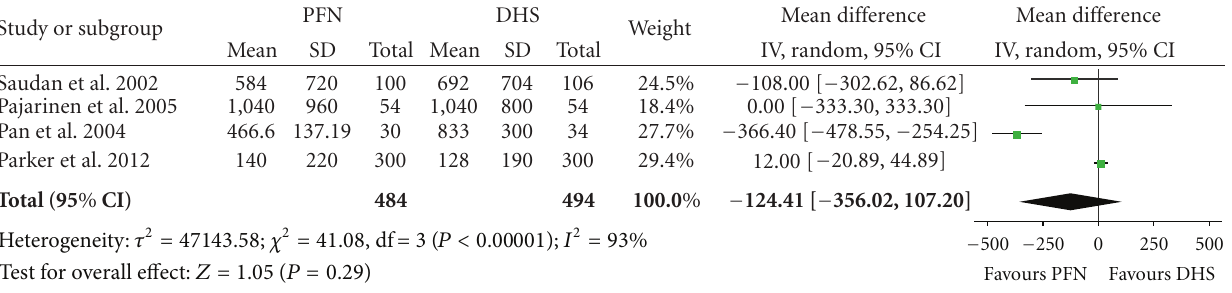
Figure 4: Comparison of blood transfusion between PFN and DHS.